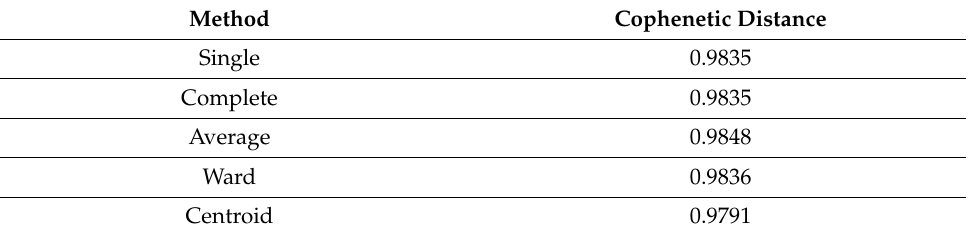
Table 1. Correlation between the cophenetic distance and the distance matrix for the different clustering methods using the FT-IR (Fourier transform infrared spectroscopy) spectrum of all the pure juice samples (D 76 × 540